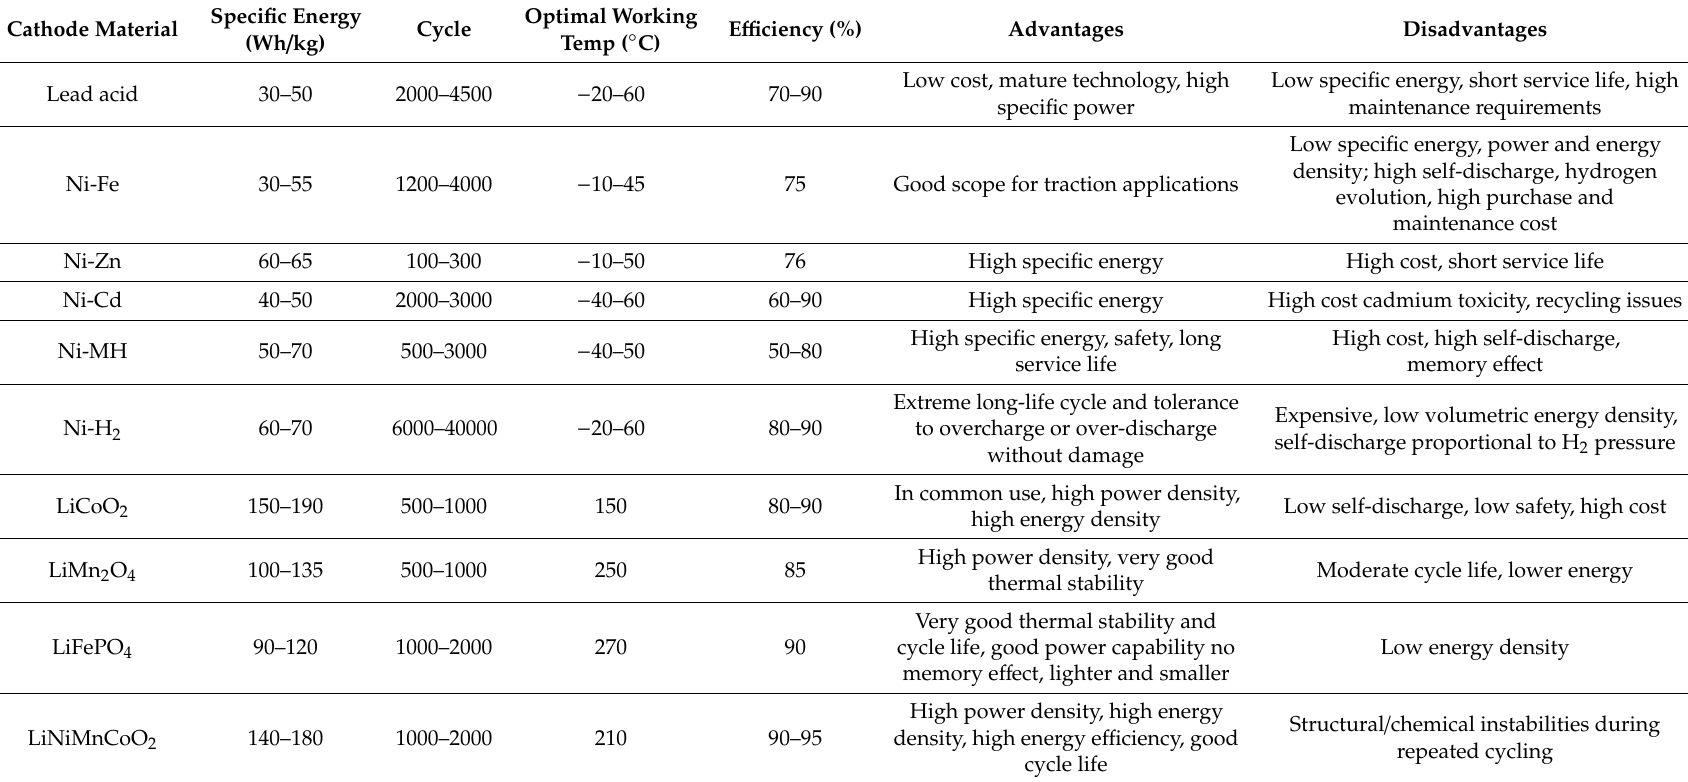
Table 1. Comparison of the most commonly used